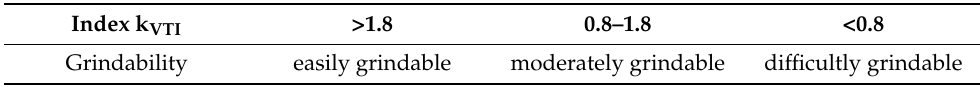
Table 1. Grindability class based on the grindability index value.